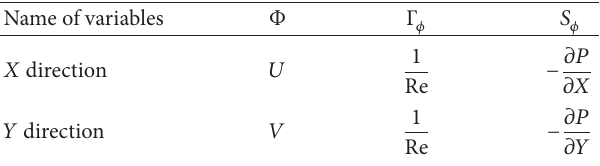
Table 1: Parameters of equations for MAC of lid-driven flow.